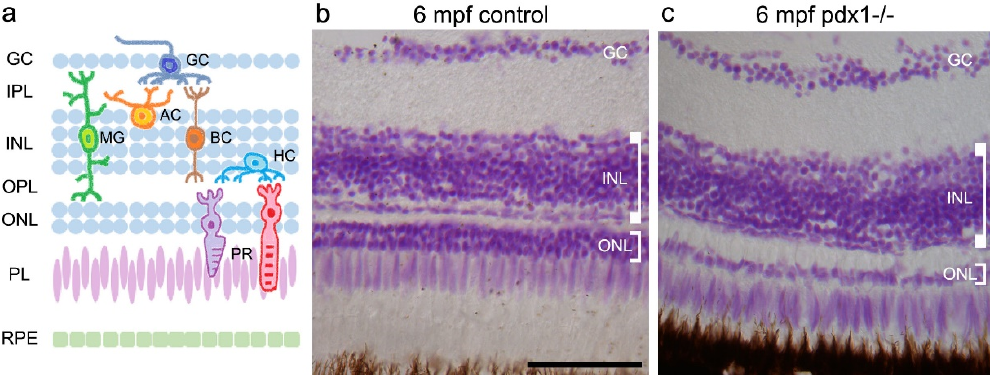
Figure 1. Pathology in the neural retina of pdx1 − / − mutants at 6 mpf. ( a ) Schematic showing the locations of the cell types of the neural retina. Feulgen staining of cryosections of control ( b ) and pdx1 mutant ( c ) zebrafish. Scale bar: 50 μ m. (GC, ganglion cell layer; IPL, inner plexiform layer; INL, inner nuclear layer; OPL, outer plexiform layer; ONL, outer nuclear layer; PL, photoreceptor layer; RPE, retinal pigment epithelium; AC, amacrine cell; MG, Müller glial cell; BC, bipolar cell; HC, horizontal cell; PR, photoreceptor).